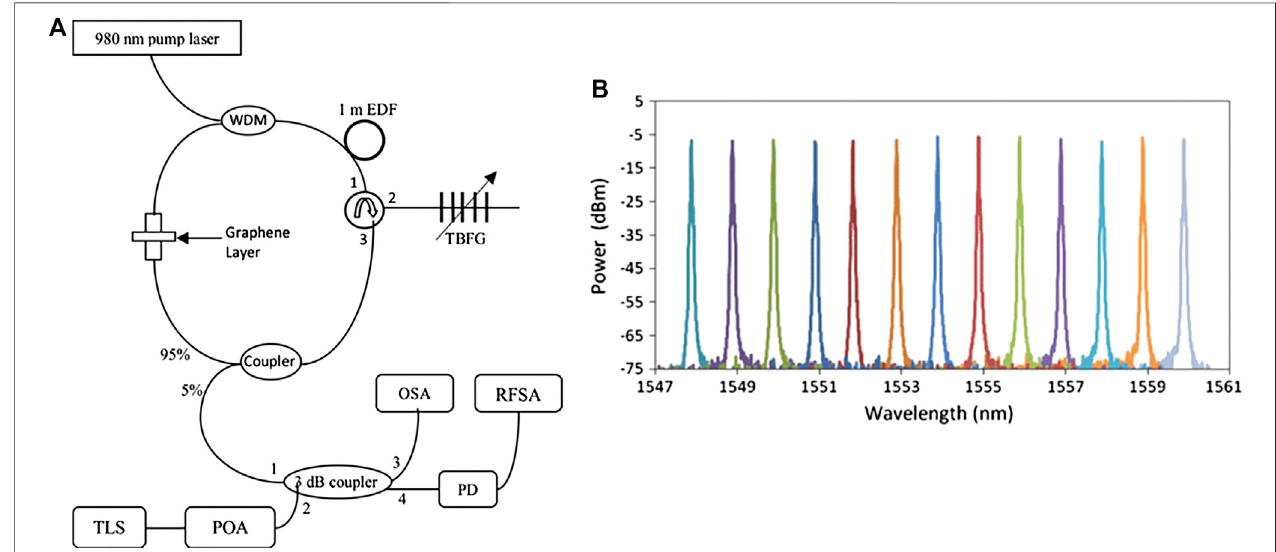
FIGURE 11 | (A) Experimental setup for tunable microwave generation by beating two SLM wavelengths from a tunable SLM ring fi ber laser and external TLS. (B) Output spectra vs. wavelengths of the ring fi ber laser. Copyright 2012, Optical Society of America.